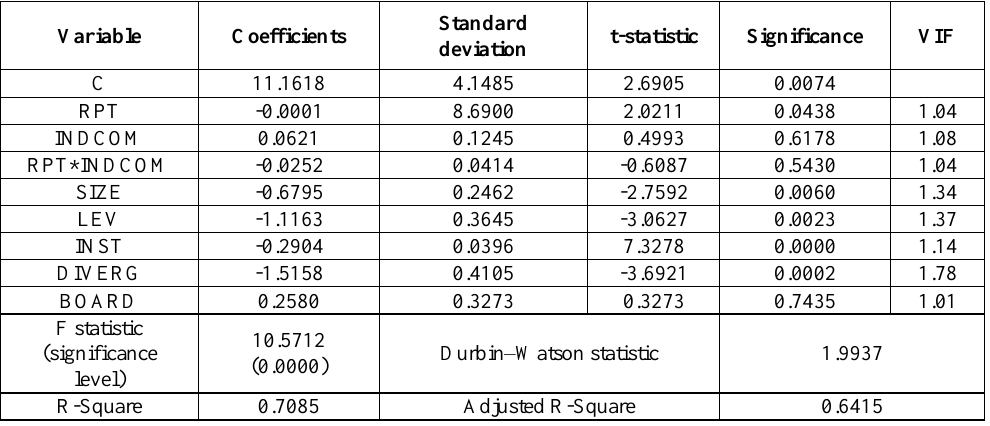
Table 5. The results of the second model (dependent variable is market value)